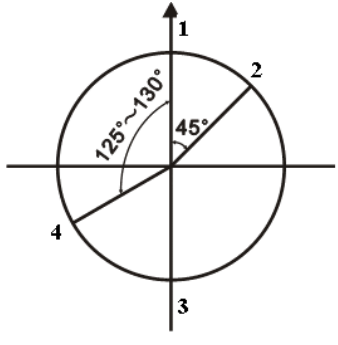
Fig. 1 Schematic diagram of cross-section temperature measurement